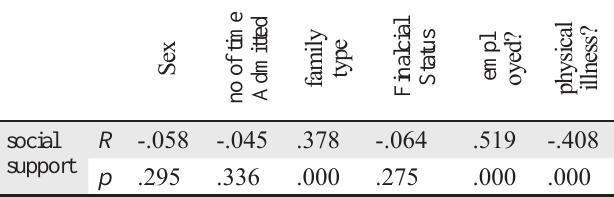
Table 3: Correlation between social support and